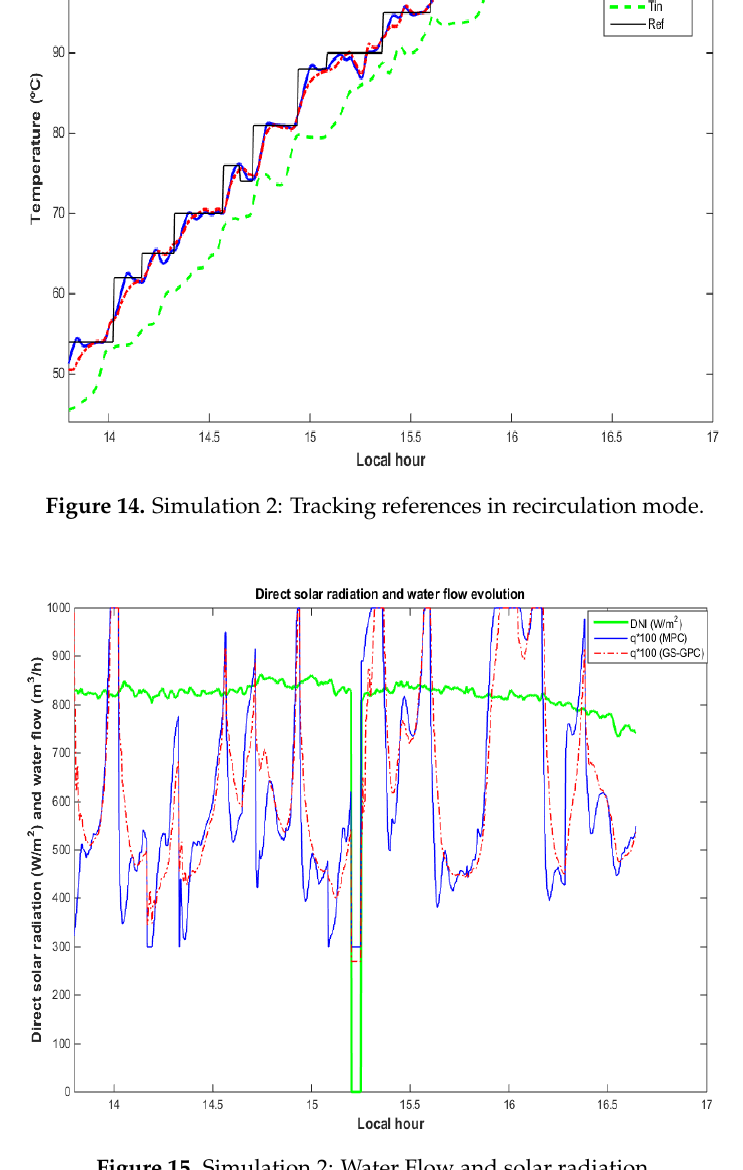
Figure 15. Simulation 2: Water Flow and solar